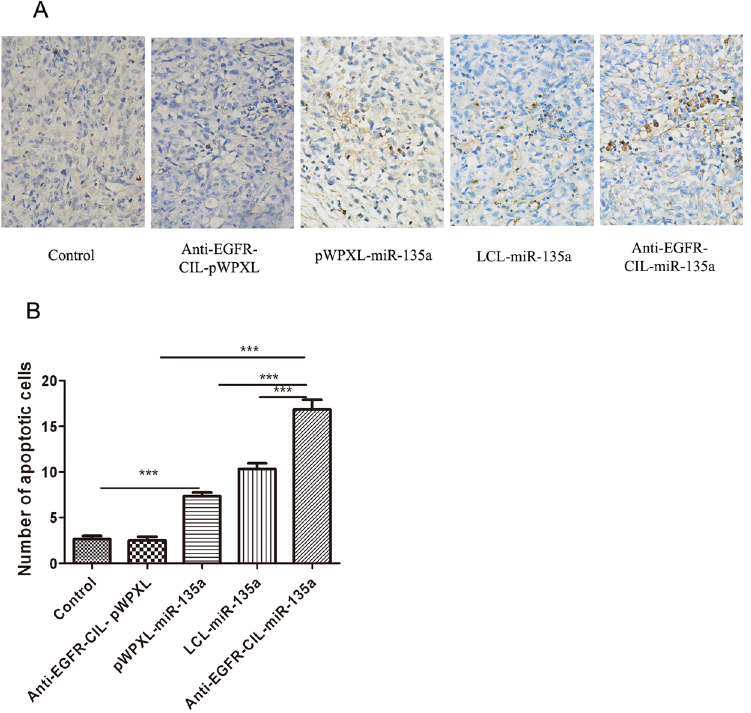
Figure 10. TUNEL assay results for apoptotic cells in GBC-SD cancer ( A ). Quantitative data were shown in ( B ). Data were represented as the mean ± SD (n = 5) ( * p < 0.05; ** p < 0.01; *** p <